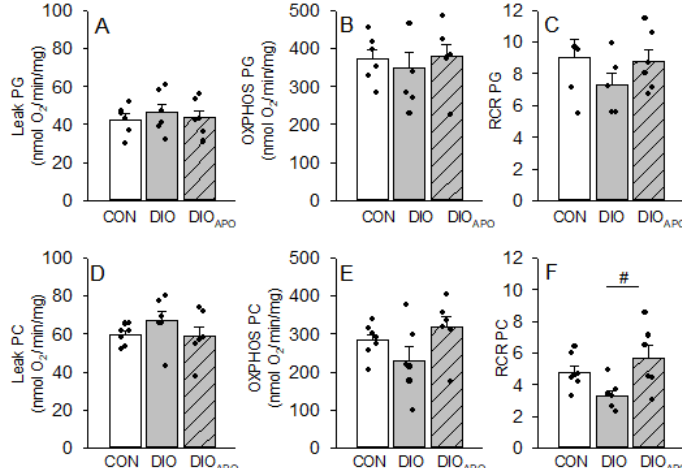
Figure 6. Oxygen fluxes (leak and maximal mitochondrial respiration capacity, OXPHOS) and respiratory coupling ratio (RCR) in isolated cardiac mitochondria using pyruvate and glutamate